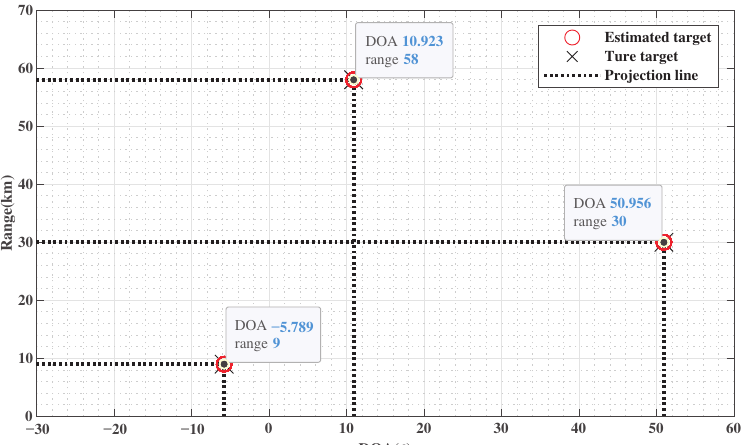
Figure 4. 2D point cloud of estimated